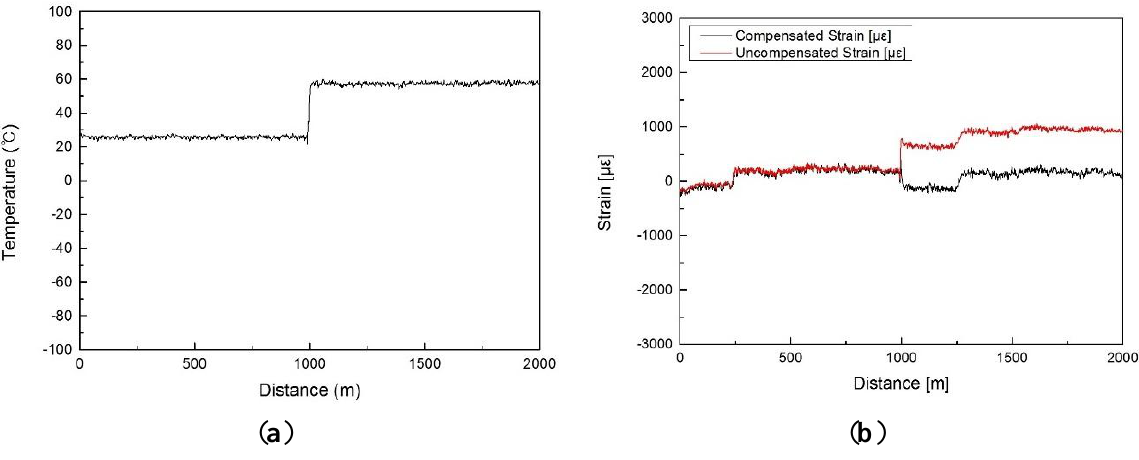
Figure 8. Distributed ( a ) temperature and ( b ) strain profiles measured from the developed BOTDR